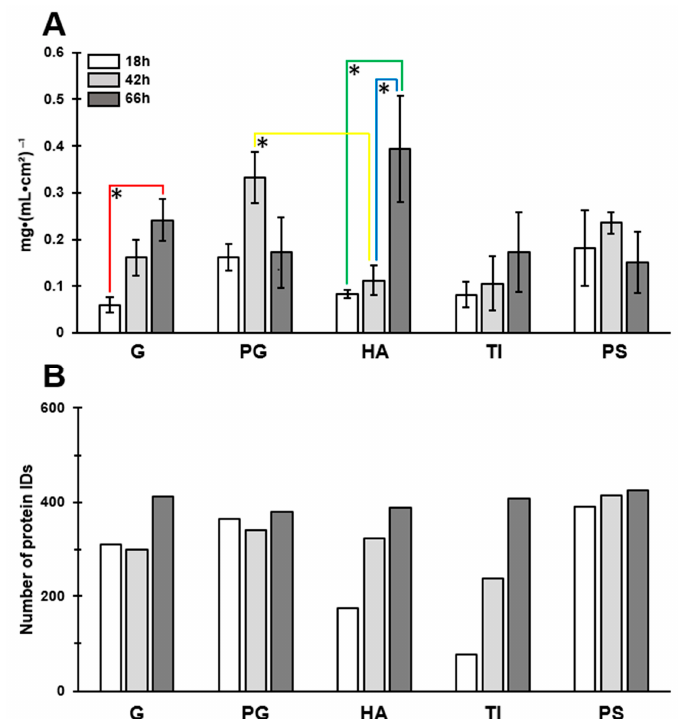
Figure 5. Protein concentrations mg·(mL·cm 2 ) − 1 ( A ) and the number of the identified matrix-associated proteins (detected in both replicates) ( B ) of the S. aureus ATCC 25923 biofilms. Differences in protein concentrations were assessed for a single material between different time points, and for a fixed time point between the different materials, using one-way ANOVA comparisons and Tukey post-tests for blank-corrected data points. *, significant difference ( p < 0.05). Error bars denote the standard error of the mean (SEM) ( n = 2). G, borosilicate glass; PG, plexiglass; HA, hydroxyapatite; TI, titanium; PS, polystyrene.